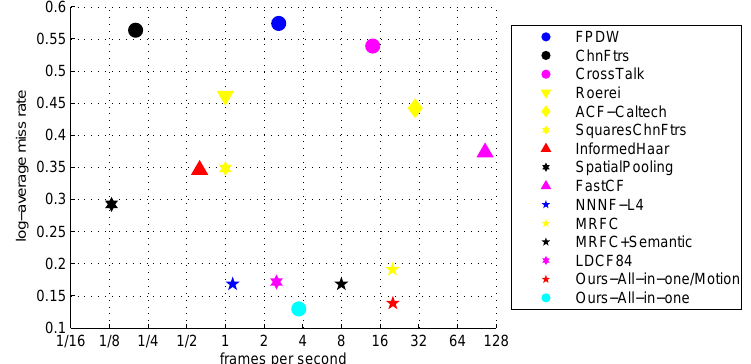
Figure 11. MR versus FPS on the Caltech